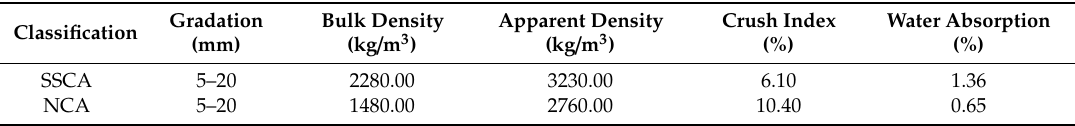
Table 1. Physical properties of coarse